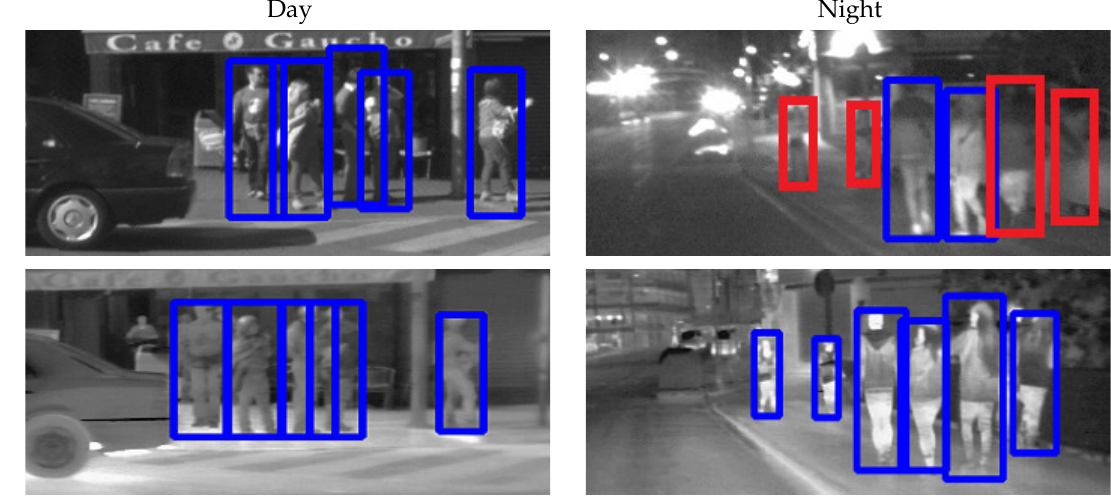
Figure 5. Qualitative Results comparing HOG/LinSVM detectors in different time/sensor conditions. The top row shows results over visible spectrum images, the bottom row over far infrared images. Blue boxes represent correct detections (True Positive), while red boxes represent misdetections (False